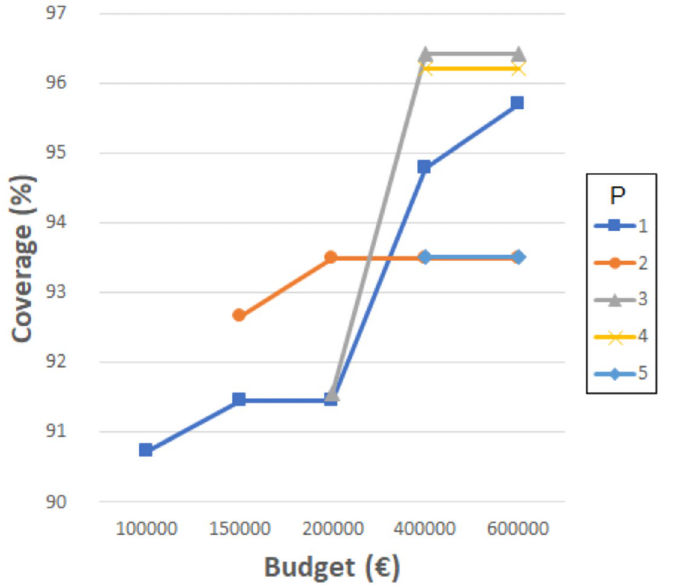
Fig 5. Coverages for 1500 meters.